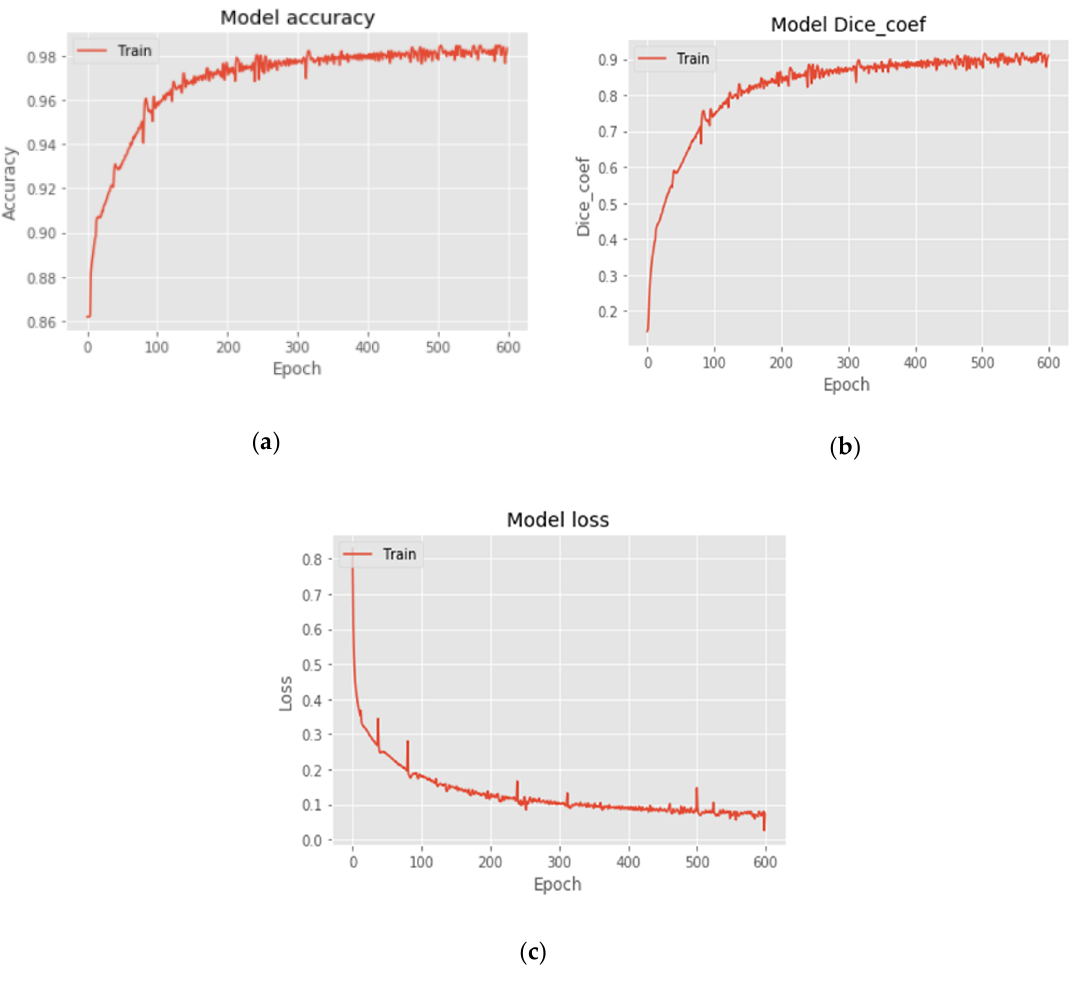
Figure 2. Evaluation of the proposed model in terms of ( a ) the overall accuracy, ( b ) the DSC, and ( c ) the loss.